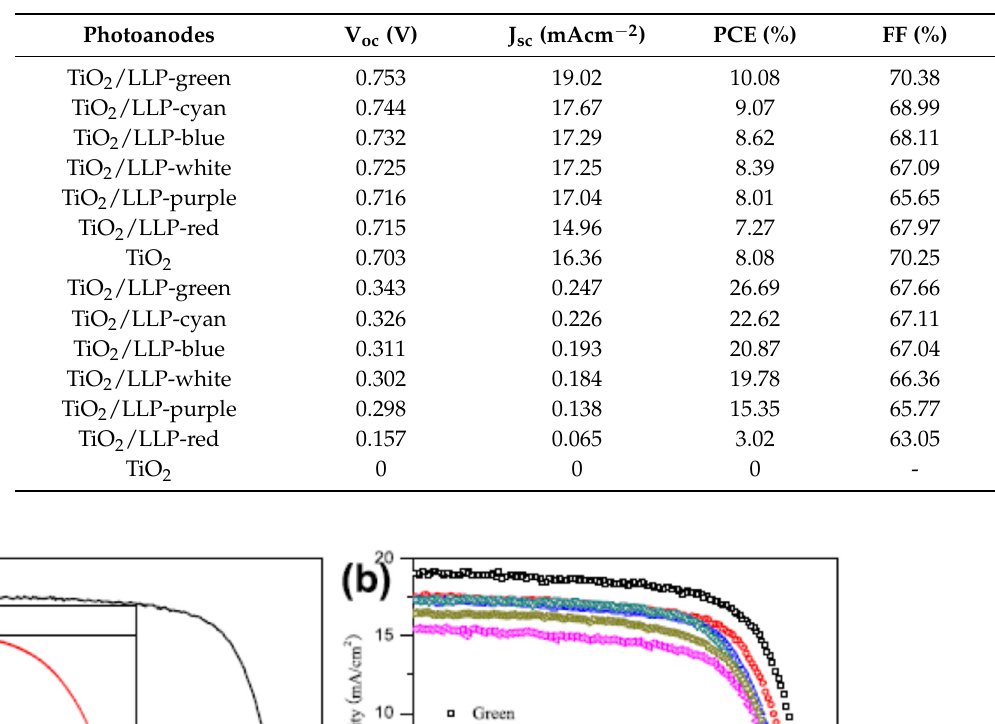
Table 5. The photo (first part) and dark (second part) photovoltaic parameters for corresponding solar cells. η : power conversion efficiency; V oc : open-circuit voltage; J sc : short-circuit current density; FF: fill factor. Reproduced with permission from [10] © 2021 Elsevier B.V.